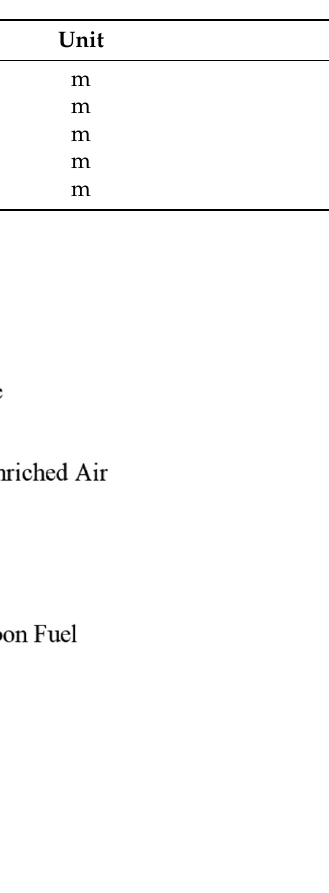
Table 1. Detailed parameters of a typical TSL furnace.